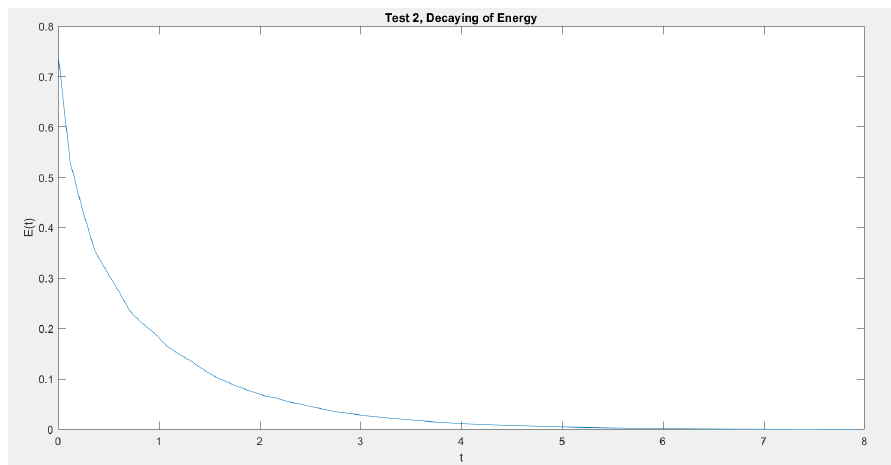
Figure 5. Test1: The energy decay.